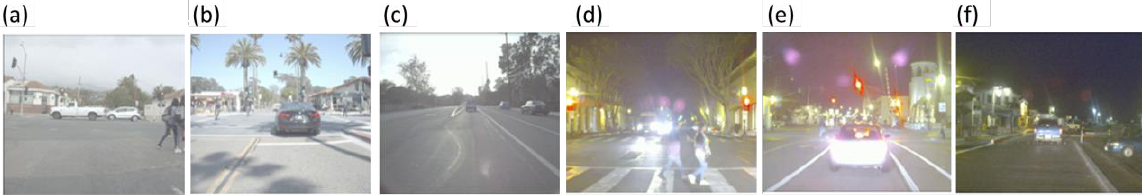
Figure 2. Diverse scenes, lighting conditions, and different road users. ( a – c ): Day images are ( a ) a cloudy sky, a city junction, a and mixed scene (pedestrians, cars); ( b ) a clear sky, a city junction, and a mixed scene (pedestrians, cars); and ( c ) a dazzling low-sun, intercity highway. ( d – f ): Night images are ( d ) dazzling lights, a city junction, and a mixed scene (partially lighted pedestrians, cars); ( e ) backscatter flashing; and ( f ) an urban street with low luminance.